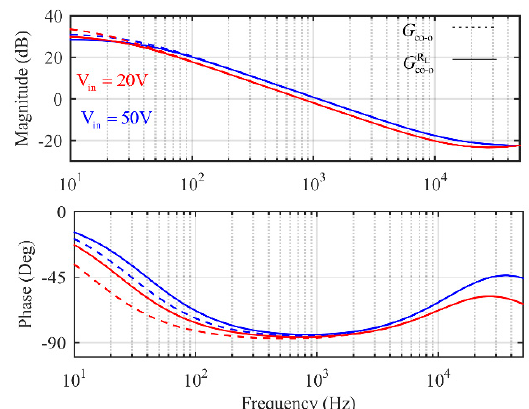
Figure 7. The dashed lines denote the predicted unterminated control-to-output-voltage frequency responses, and the solid lines denote the predicted load-resistor-affected frequency responses at the input voltages of 20 V (red) and 50 V (blue).